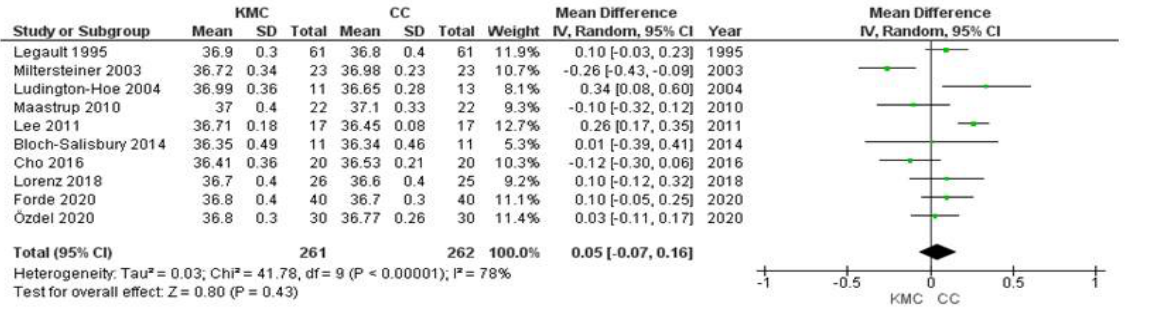
Figure 7. Forest plots for effects of KMC compared with conventional care on temperature (°C).